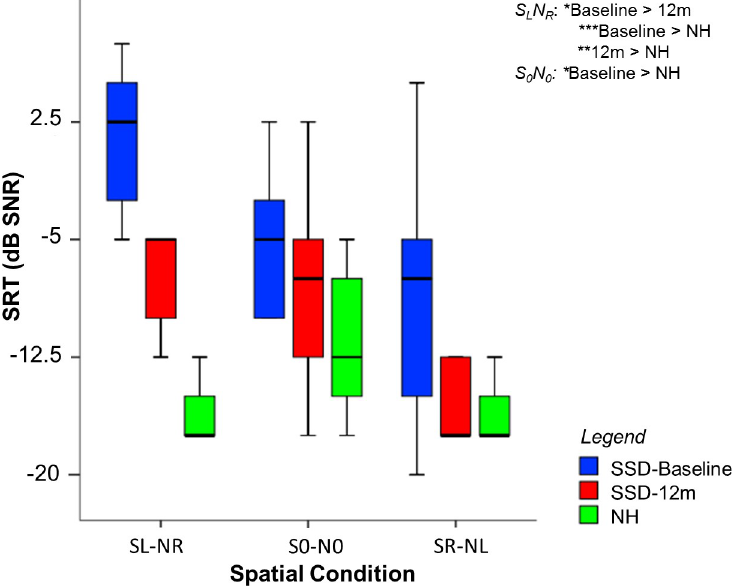
Fig 1. Boxplots of SRTs in noise for the three spatial conditions: SL-NR, S0-N0, and SR-NL. The blue and red boxes show SSD-CI SRTs at baseline at 12m post-activation, respectively; the green boxes show NH data. The boxes show the 25 th and 75 th percentiles, the error bars show the 5 th and 95 th percentiles, the solid line shows the median. Significant differences are shown at top right ( � = p < 0.05, �� = p < 0.01, ��� = p < 0.001, from Wilcoxon tests).